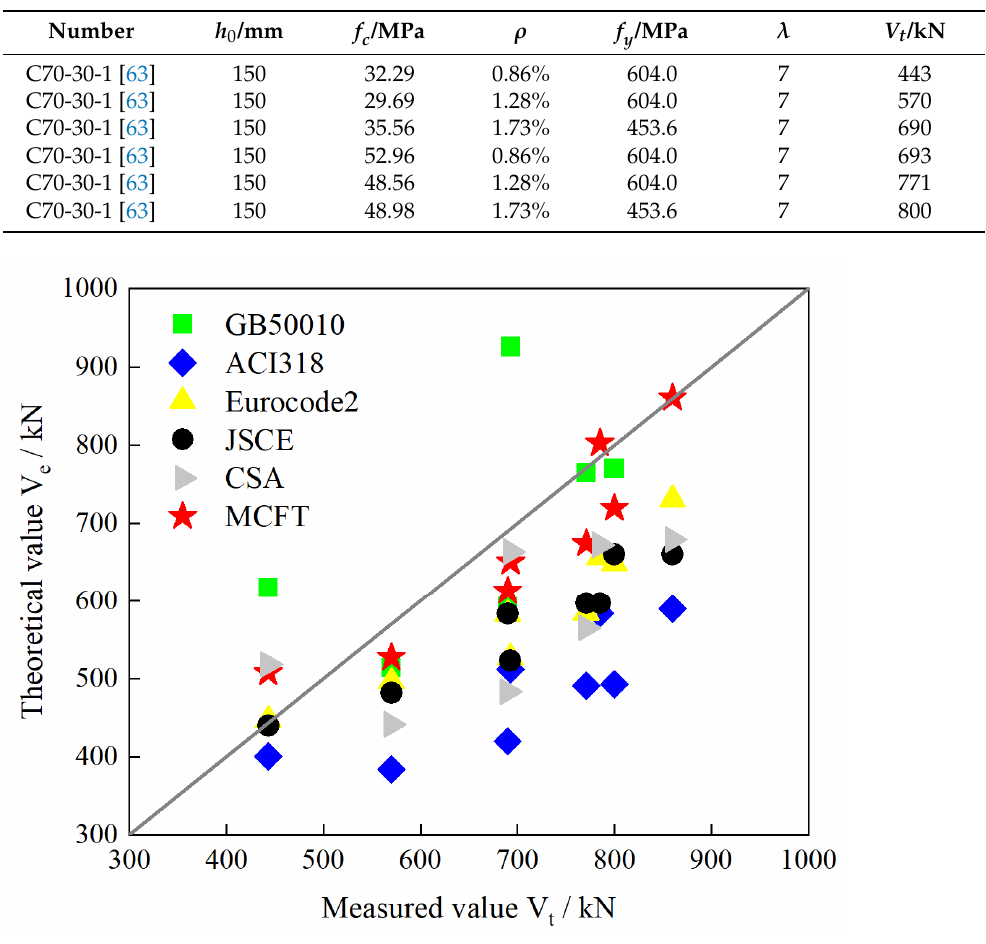
Figure 14. Comparison of MCFT with design codes.